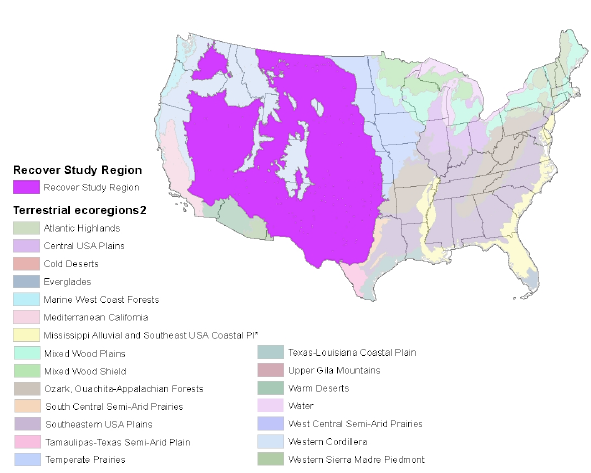
Figure 1. Savanna ecosystem to be